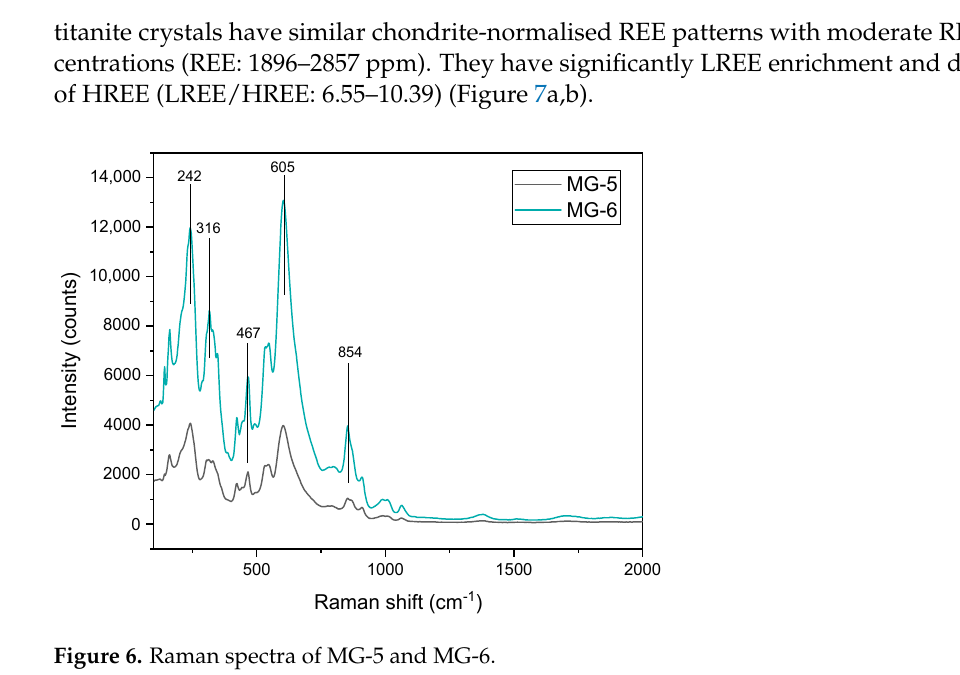
Figure 6. Raman spectra of MG-5 and MG-6.